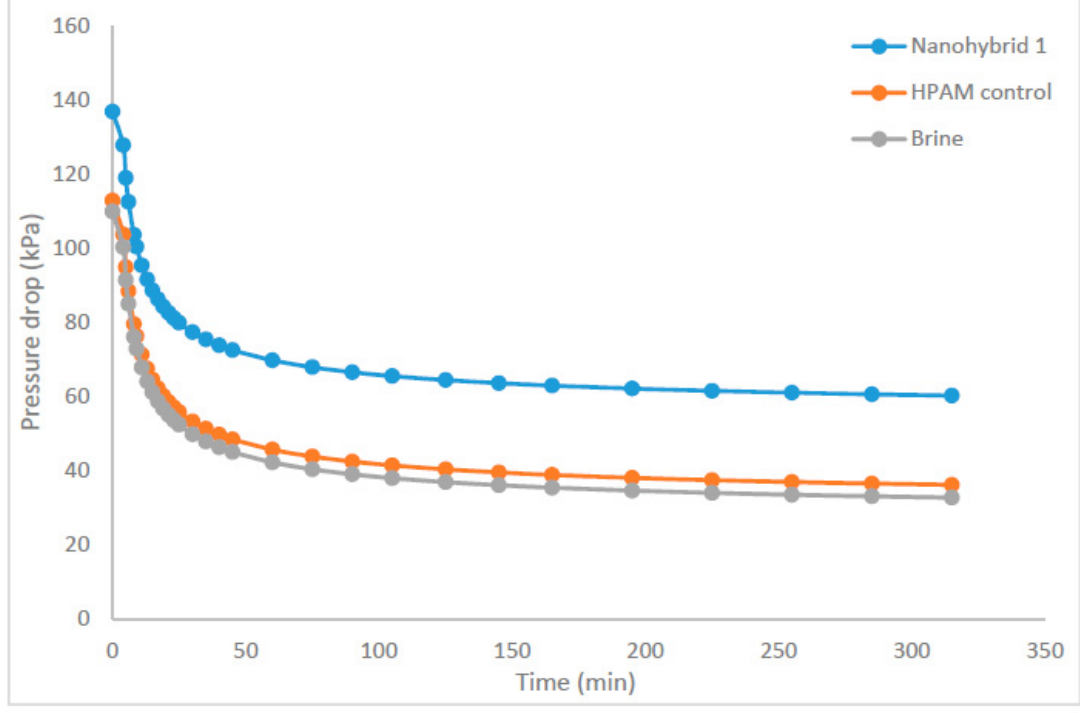
Figure 12. Pressure drop inside the sandpack during nanohybrid 1, HPAM, and brine flooding.